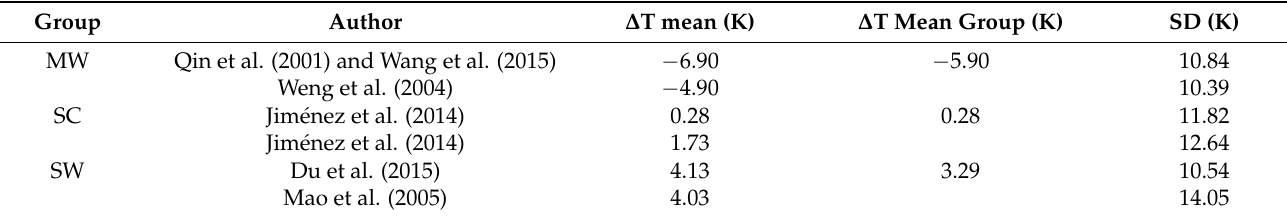
Table 6. Comparison of LST estimates according to